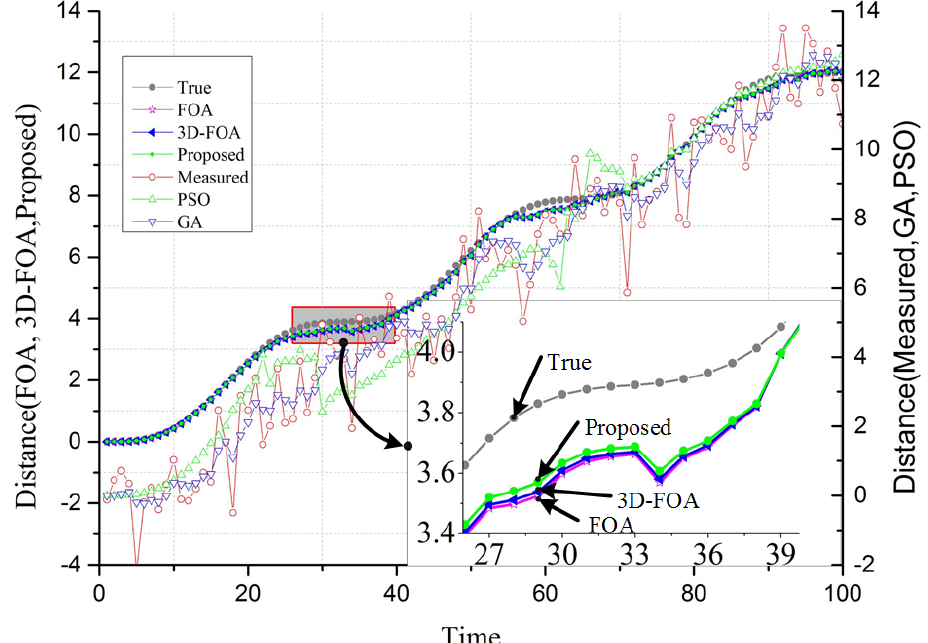
Figure 7. The estimation results of pushing distance using different optimization algorithms with an artificial signal.